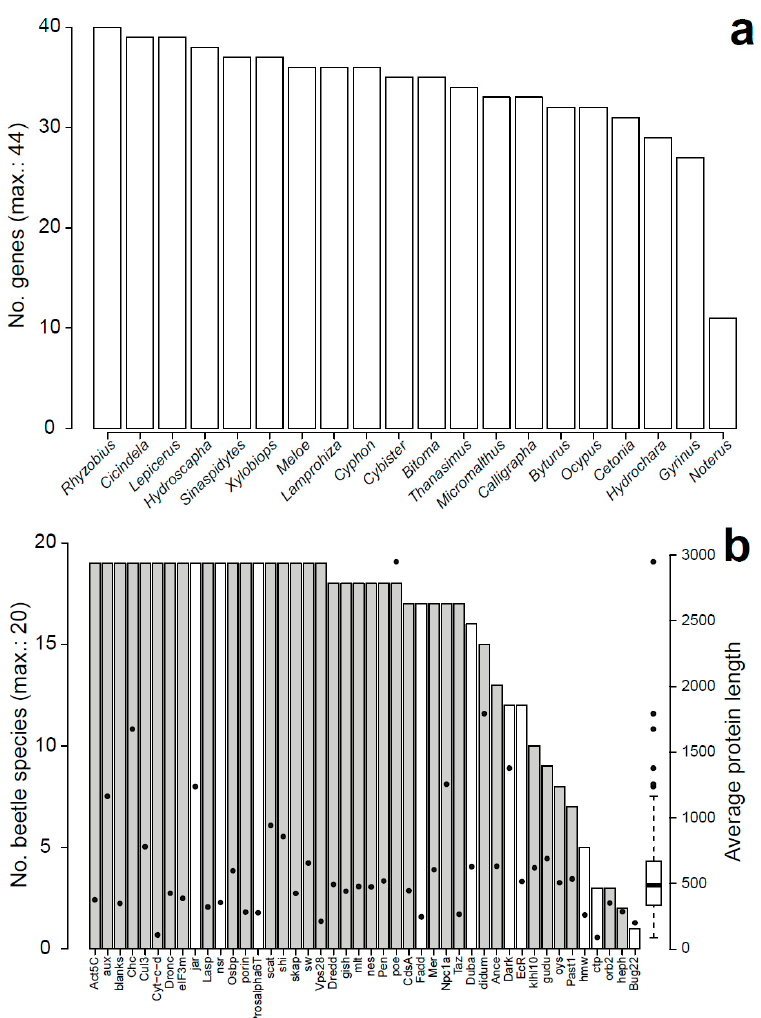
Figure 2. Performance of Orthograph searches of sperm individualization gene orthologs in beetle transcriptomes. ( a ) Number of genes retrieved from each of the non-model beetle species transcriptomes. ( b ) Number of beetle species yielding ortholog sequences for each of the sperm individualization genes analyzed, with information on the average protein length and showing genes absent in one or more OrthoDB beetle model species as white columns.